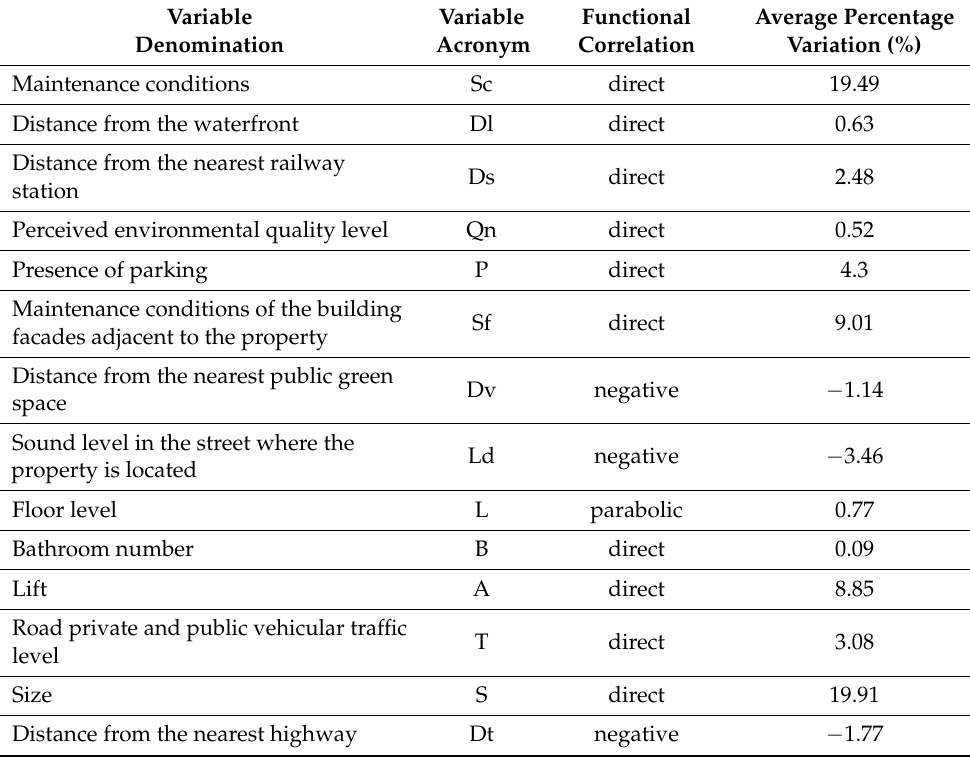
Table 4. Total selling price average percentage variation for the variables chosen by the model for the OMI semi-central area of the city of